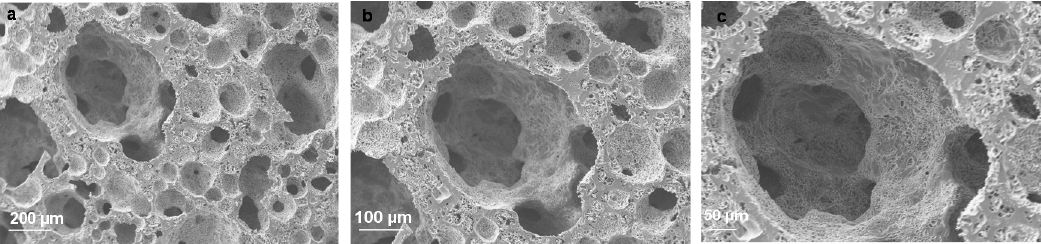
Figure 2. The micro and macroporous structure of PLEOF-methacrylated gelatin interpenetrated network. Figure reproduced from [138], with permission from Elsevier.